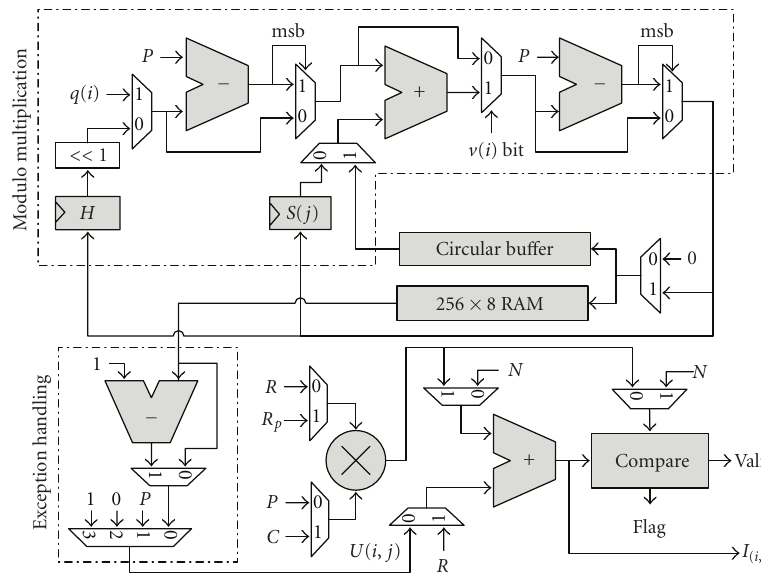
Figure 12: WCDMA turbo code interleaver hardware.